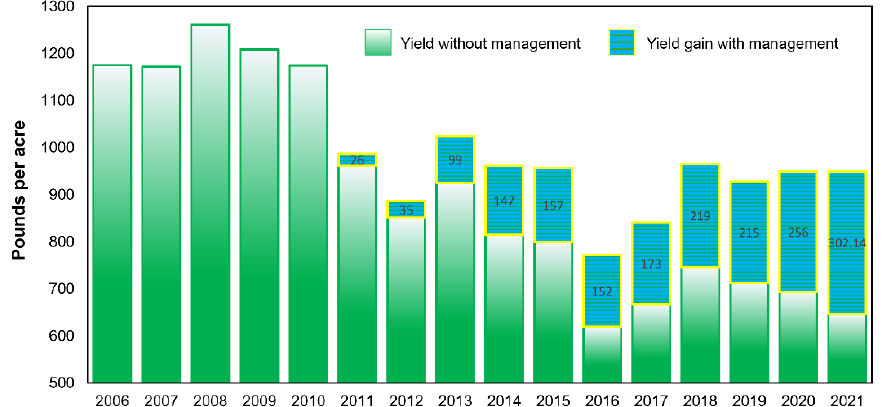
Figure 3. Average coffee yield (pounds of parchment coffee per acre) across all Hawaii farms from 2006 to 2021 and gain in yield due to all combined CBB management beginning in 2011.